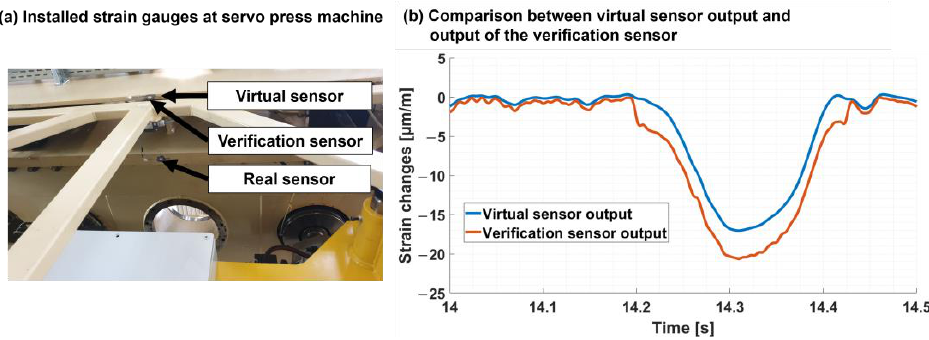
Figure 8. Verification of the developed virtual sensor model.